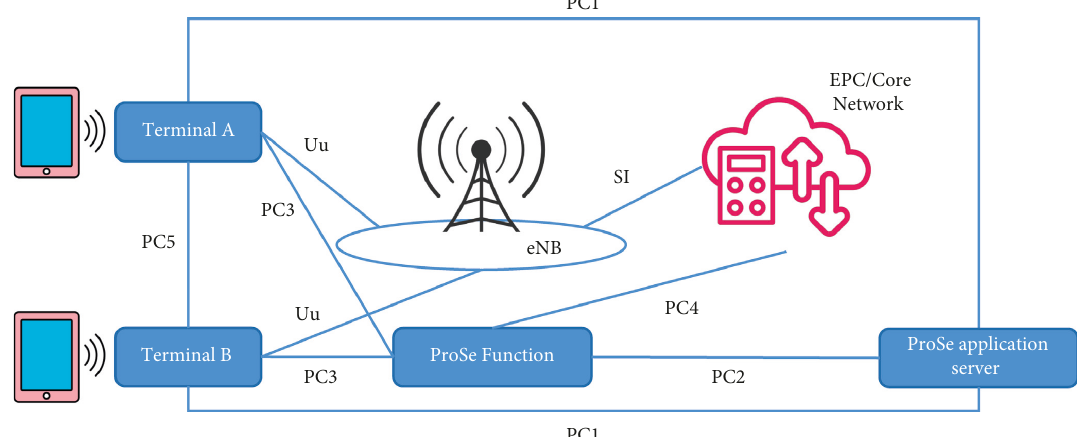
Figure 1: Schematic diagram of network architecture based on